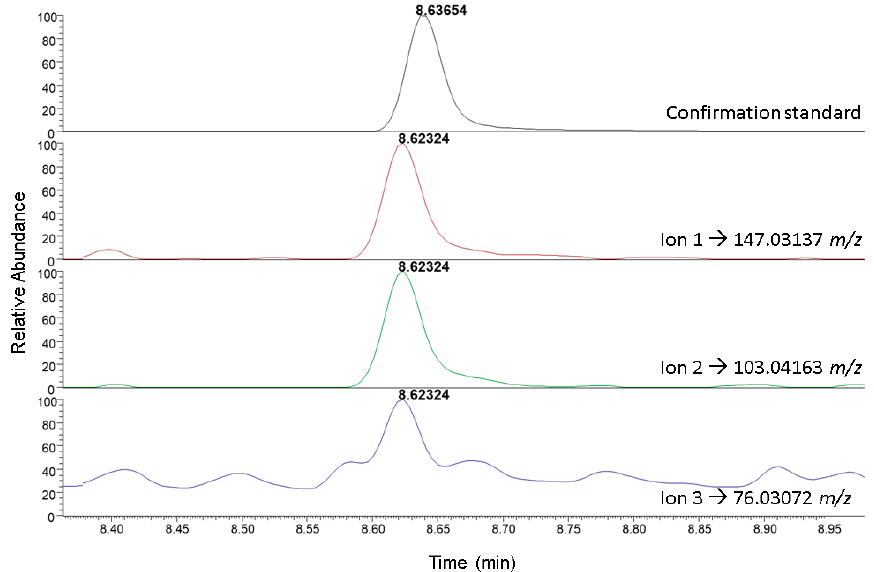
Figure 1. Extracted ion chromatograms of phthalimide in a sample of orange juice and the confir- mation standard used. Table 3. Suspect residues detected in fruit and juice samples.